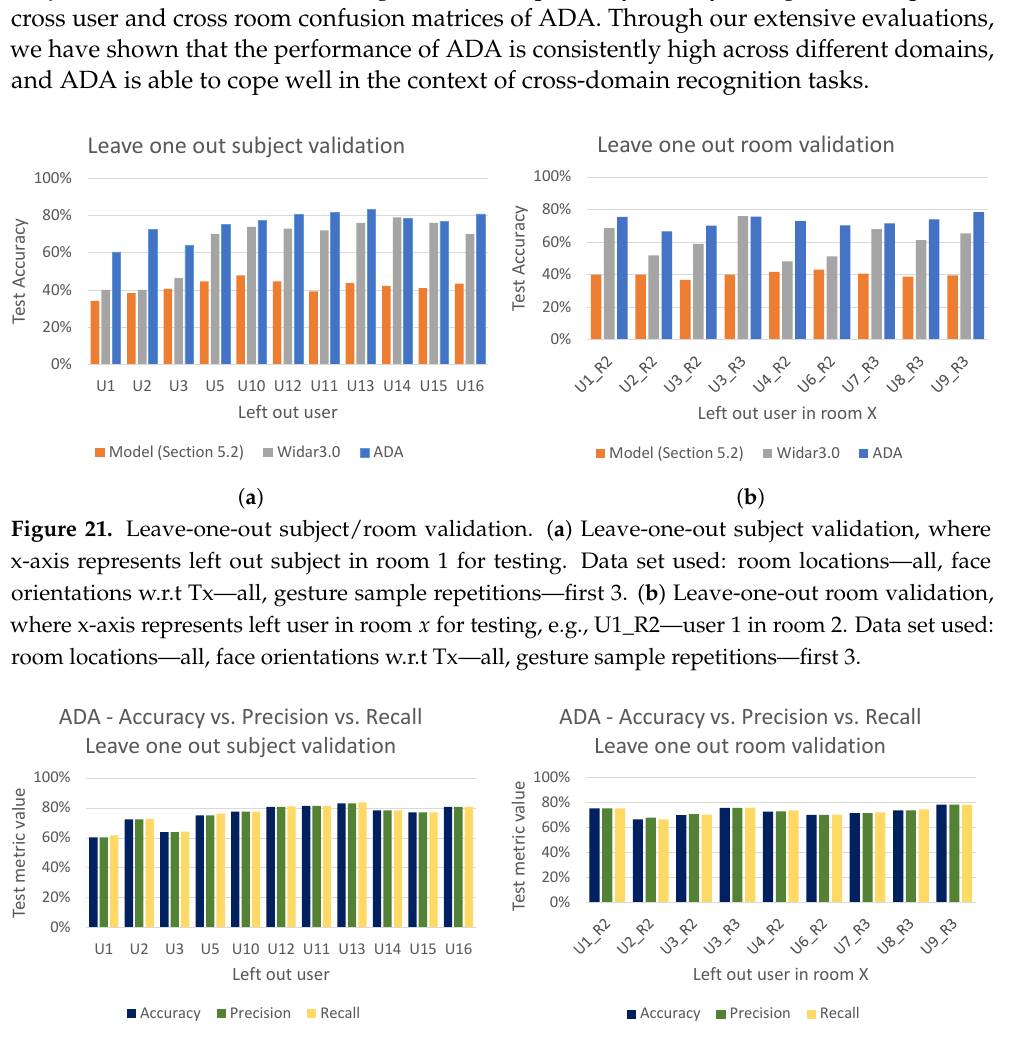
Figure 22. ADA—Accuracy vs. Precision vs. recall. ( a ) Leave-one-out subject validation, where x-axis represents left out subject in room 1 for testing. ( b ) Leave-one-out room validation, where x-axis represents left user in room x for